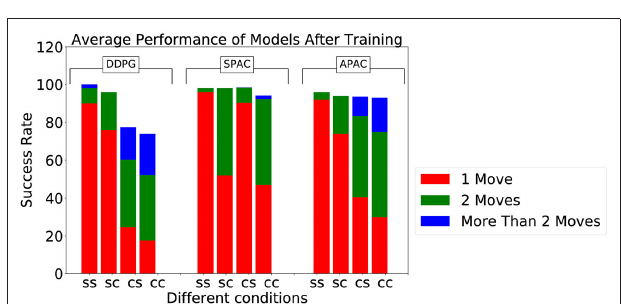
FIGURE 5 | Success rate to reach targets during testing by three models under different conditions, where “ss,” “sc,” “cs,” and “cc” stand for static target/static kinematics, static target/changing kinematics, changing target/static kinematics, and changing target/ changing kinematics, respectively. The plot also displays the average number of steps to reach 100 targets after